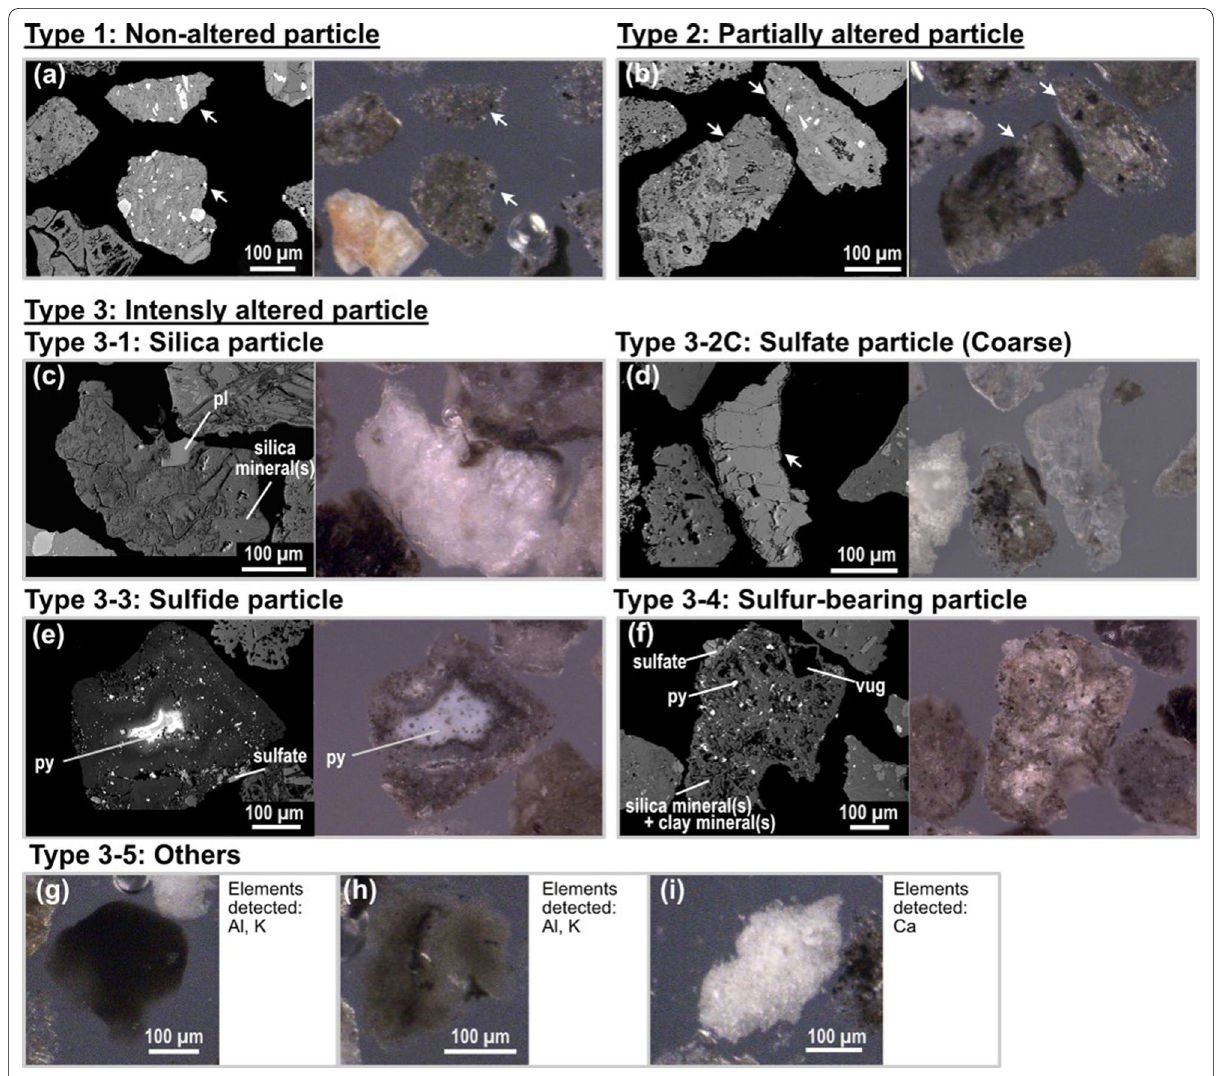
Fig. 6 Representative images of classified ash particles as backscattered electron images and optical digital microscope images. Arrows in a, b and d indicate the particles classified in each category. Sulfate, alunite and simple sulfate minerals such as anhydrite and gypsum; py pyrite, pl